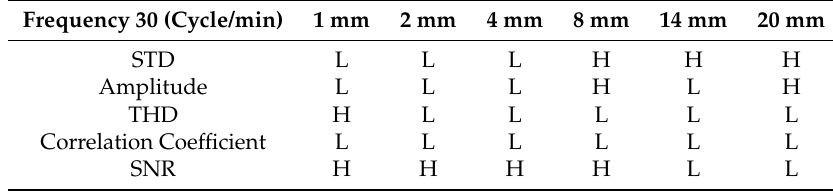
Table A15. Values higher and lower than the median Frequency 30 cycles/min for a 5 mm